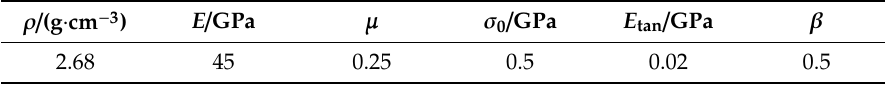
Table 7. Less weathered limestone mechanical